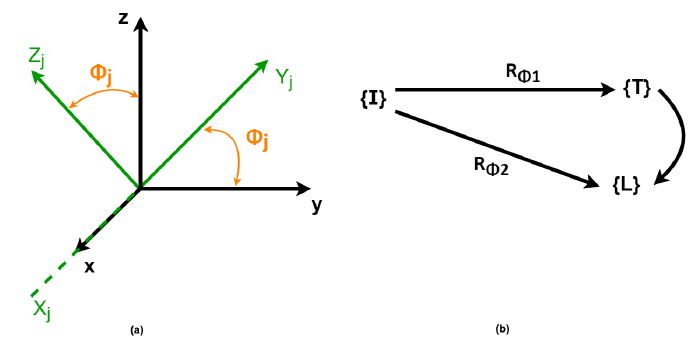
Figure 5. ( a ) Frame representation with respect to a reference frame. ( b ) Linear mapping of a frame to another.